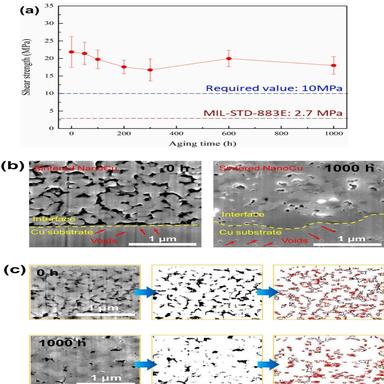
(a): Shear strength of the sintered Cu/nanoCu/Cu joints after thermal aging at 300 ◦C for different time period. (b) Comparison of cross-sectional morphology and (c) porosity of the sintered Cu/nanoCu/Cu joint before and after thermal aging at 300 ◦C for 1000 h.